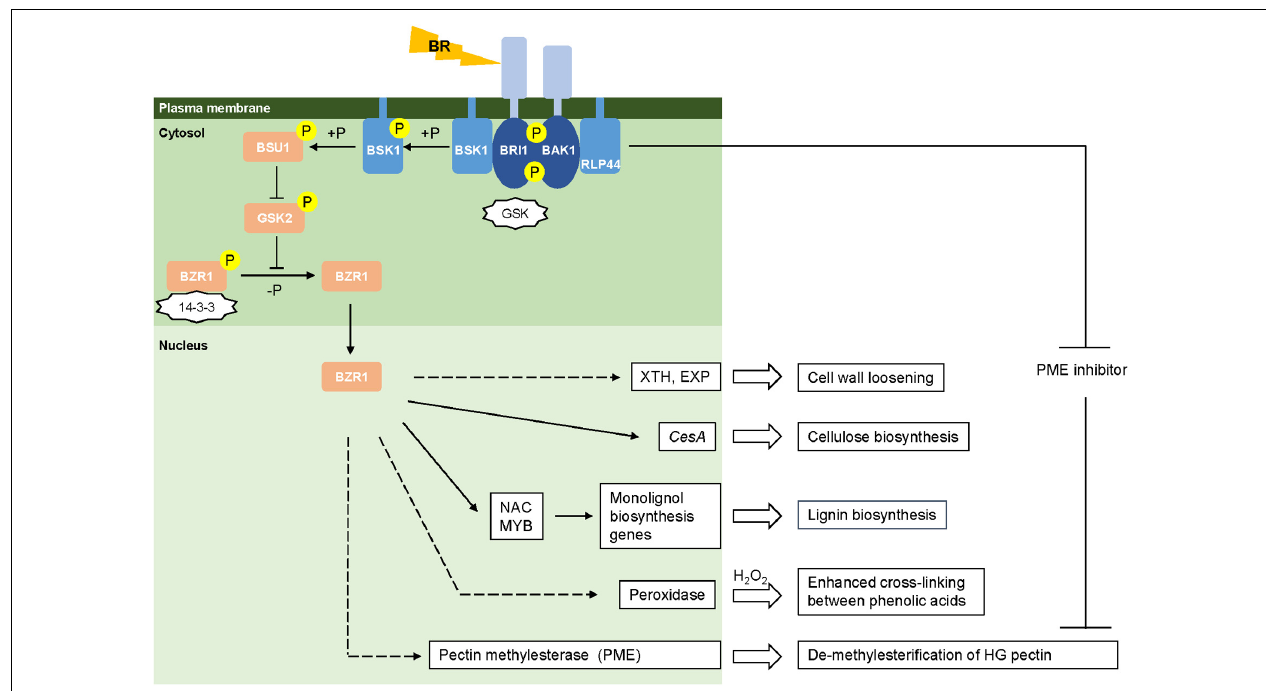
FIGURE 1 | Brassinosteroid mediated cell wall remodeling. Models of the BR signaling pathway are drawn based on the information from rice (Vriet et al., 2013). Activated and repressed reactions are represented by arrows and blunt-ended lines, respectively. Negative regulators (GSK and 14-3-3) are in the shape of stars. Phosphorylation and de-phosphorylation are represented by “ + P” and “ − P,” respectively. Direct and indirect regulation are represented by solid and dashed lines,